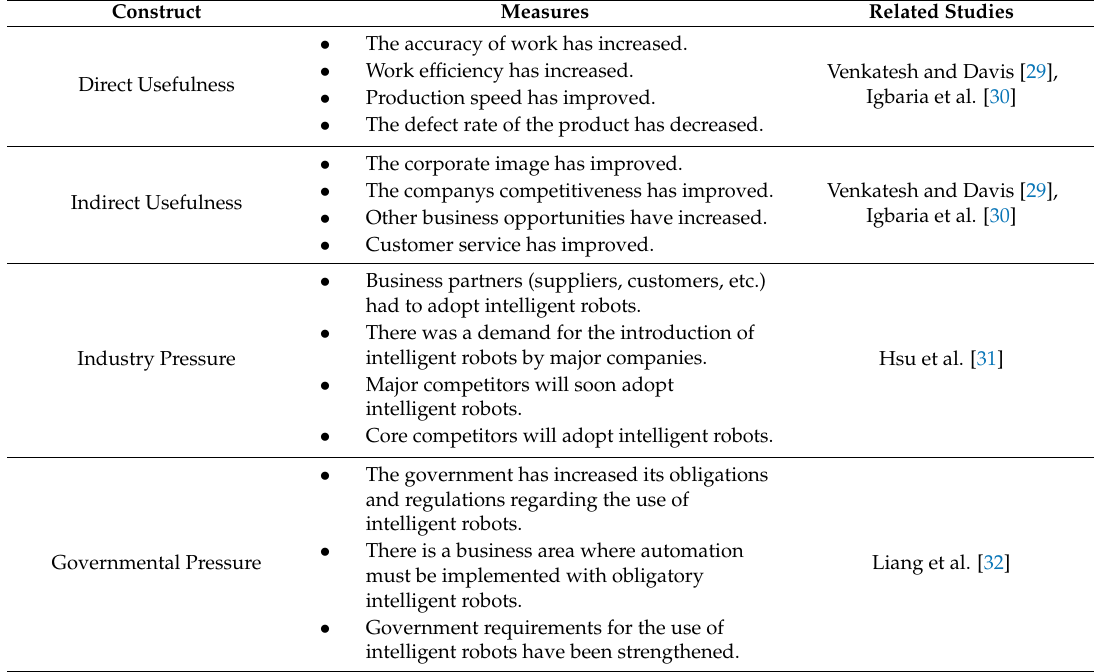
Table 2. Constructs and related